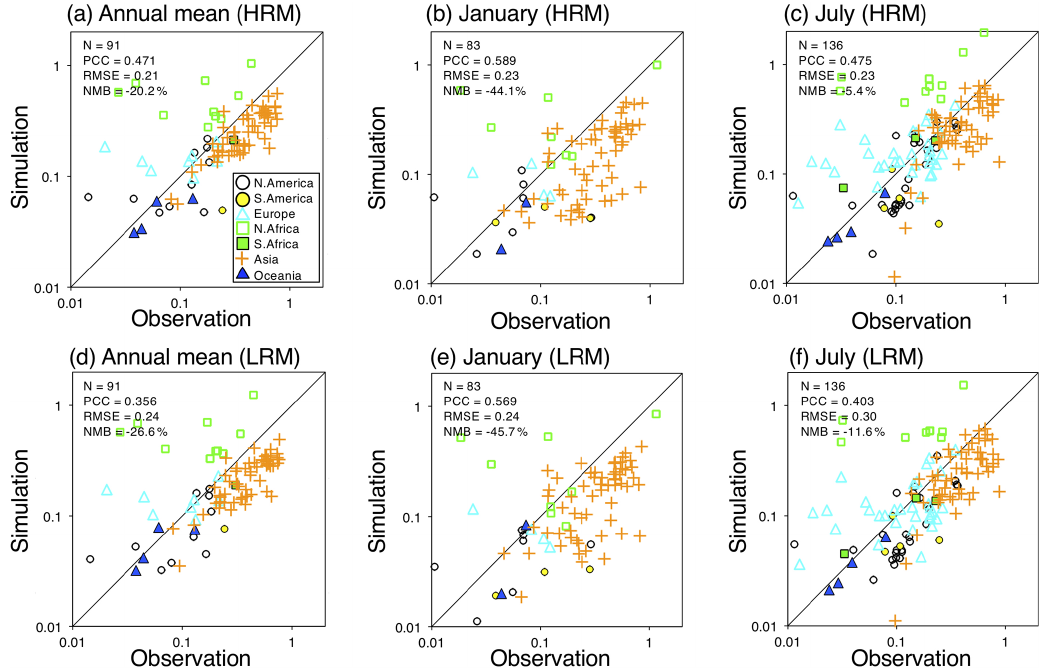
Figure 6. Scatterplot of the AOT at a wavelength of 500nm between satellite measurements (AERONET, SKYNET and CARSNET) and the NICAM (HRM and LRM) simulations for the annual, January and July averages. The different colors and marks reflect the sites in the different regions explained in panel (a) . The numbers located in the upper-left corner in each panel represent the statistical metrics: N , PCC, RMSE and NMB. The statistical metrics are also shown in Table S5. The sites used for the comparison are shown in Fig. 1.